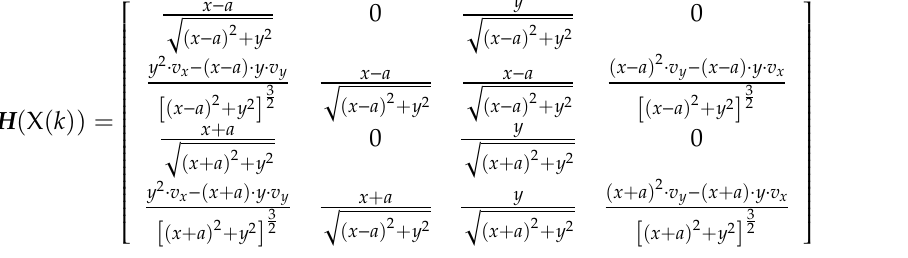
Figure 2. Flow graph of interacting multiple model extended Kalman filter (IMMEKF).